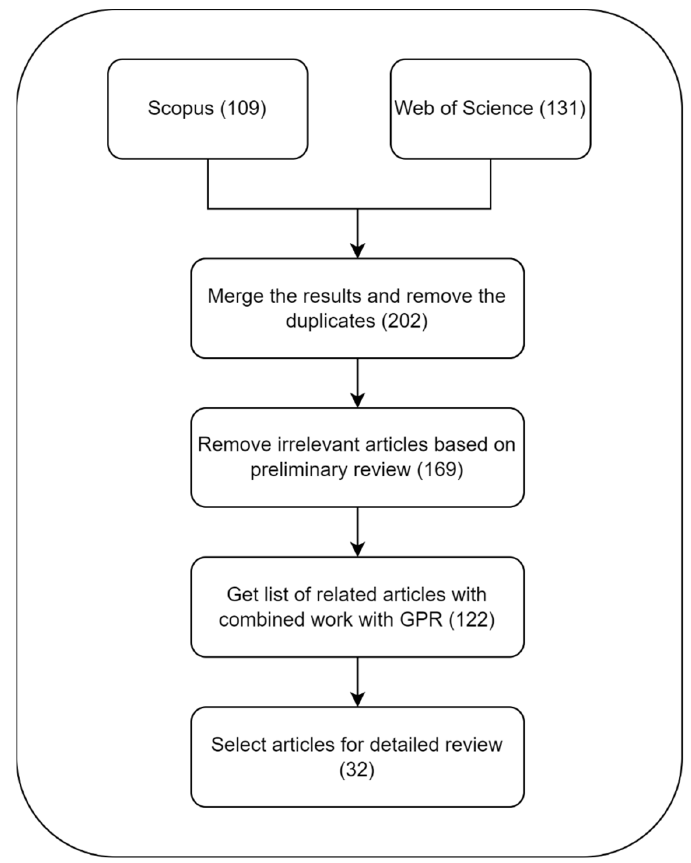
Figure 15. Flowchart for the search method.